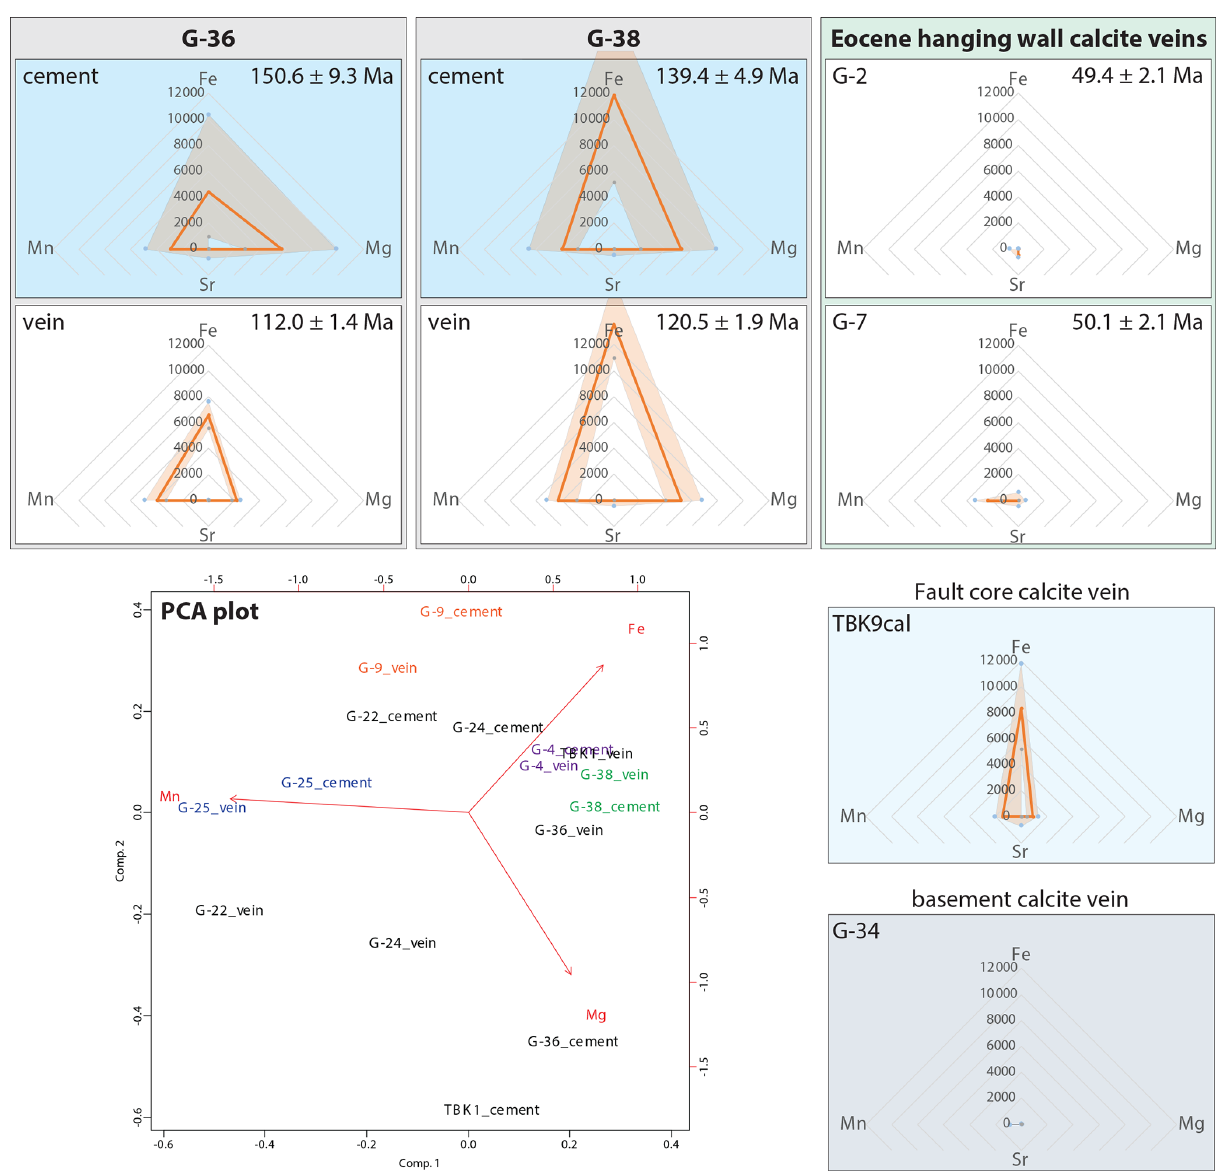
Figure 10. Diagrams showing the element concentrations of Fe, Mn, Mg, and Sr (in ppm) in calcite cements and veins. Only samples hosting both cement and veins are shown, and among those samples with multiple vein generations, only data for the thickest vein generation are shown (see Fig. S2 in the Supplement for all diagrams). Exceptions are made for Eocene, fault core, and basement samples for which only vein data exist. The solid orange line refers to mean values; the light orange envelope refers to minimum and maximum values. Note the similarity of element concentration and ratio from cement to vein especially for samples G-4, G-9, G-25, and G-38. The principal component analysis (PCA) plot of the mean values highlights the similar ratio (calculated using the provenance R package; Vermeesch et al.,